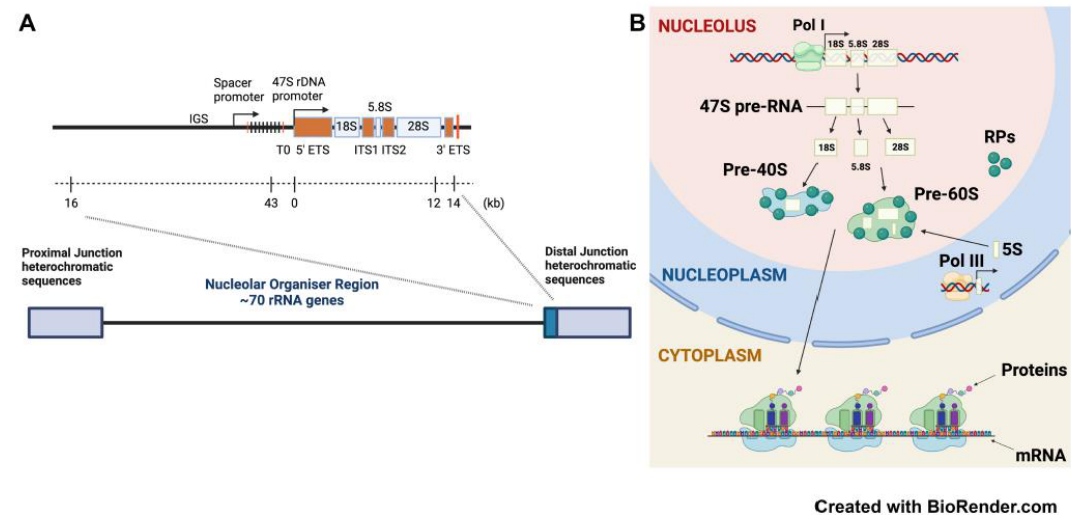
Figure 1. rDNA structure and ribosome biogenesis in mammalian cells. ( A ) Organization of ribosomal RNA (rRNA) genes in mammalian cells. Five NORs, each containing ~70 rRNA genes, are located on the short arms of the acrocentric chromosomes. A canonical rDNA unit consists of the 47S rRNA gene transcribed region made up of the 18S, 5.8S and 28S, coding regions flanked by ETS (external transcribed spacer) and ITS (internal transcribed spacer) elements, and the IGS. The IGS contains regulatory elements including spacer promoter and the 47S rDNA promoter. ( B ) Ribosome biogenesis is a tightly coordinated process involving all three RNA polymerases (Pol I, Pol II and Pol III). RNA Pol I transcribes the tandemly repeated ribosomal RNA (rRNA) genes to produce the 47S precursor rRNA (47S pre-rRNA) transcript in the nucleolus. Following transcription, the 47S pre-rRNA is subsequently cleaved and processed into the mature 18S, 5.8S, and 28S rRNA species. These molecules are then assembled with ribosomal proteins and the 5S rRNA produced by Pol II and III, respectively, to form the small (40S) and the large (60S) ribosomal subunits, which are exported from the nucleolus to the cytoplasm, where they form the mature (80S) ribosome required to initiate mRNA translation and thus protein synthesis.